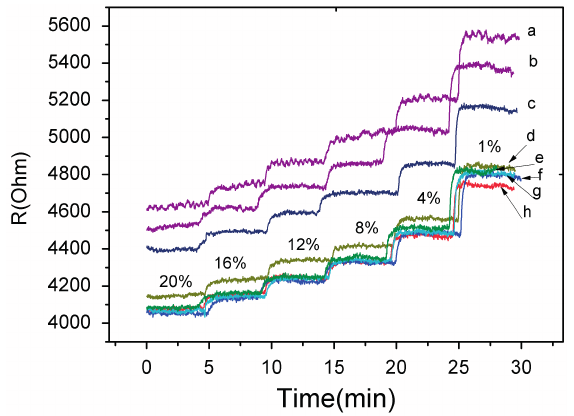
Figure 7. The response of the micro sensor based on TiO different oxygen partial pressure. a, b, c, d, e, f, g, h curves were seven results of the chip in the order of testing